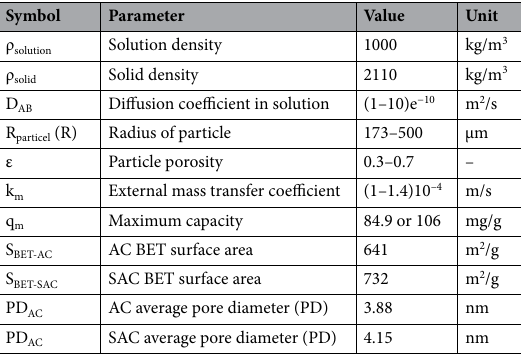
Table 1. Particle characteristic and operating conditions 19,30–32 .